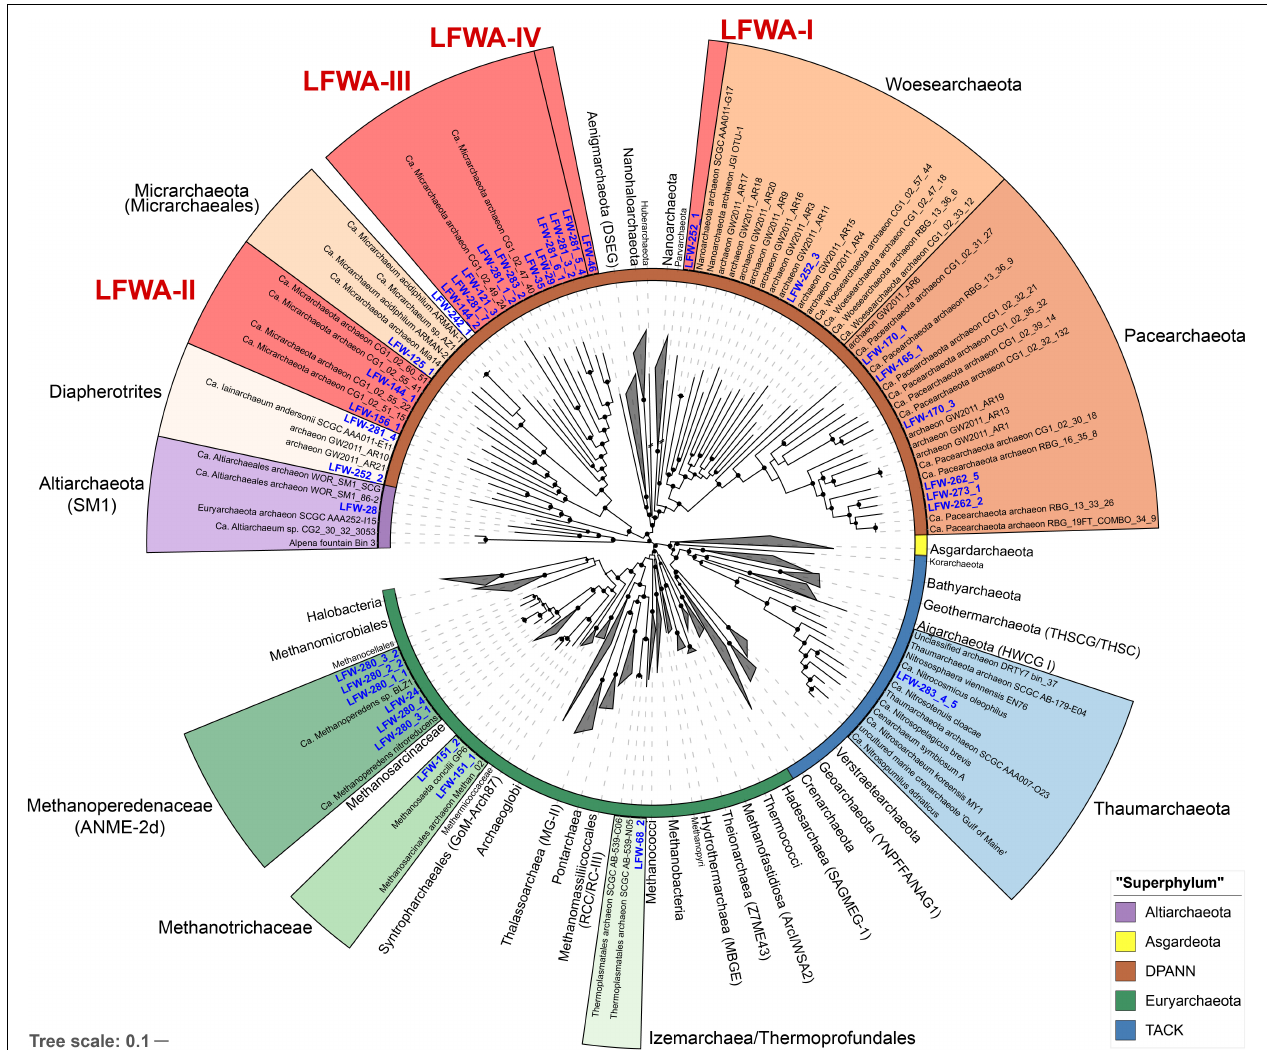
FIGURE 1 | Phylogenomic analysis of the archaeal MAGs found at LFLS. Concatenated protein tree constructed with 44 universal and Archaea -specific ribosomal proteins from 230 reference genomes and 36 original MAGs from this work. Tree was constructed with IQ-TREE under the PMSF + LG + C60 + F + I + G. Lineages with representatives at LFLS are shown coloured and uncollapsed, with labels in blue. Inner ring indicates the major archaeal lineages. Shortened branches are shown at 50% of their length. Black circles indicate ultrafast bootstrap support values >